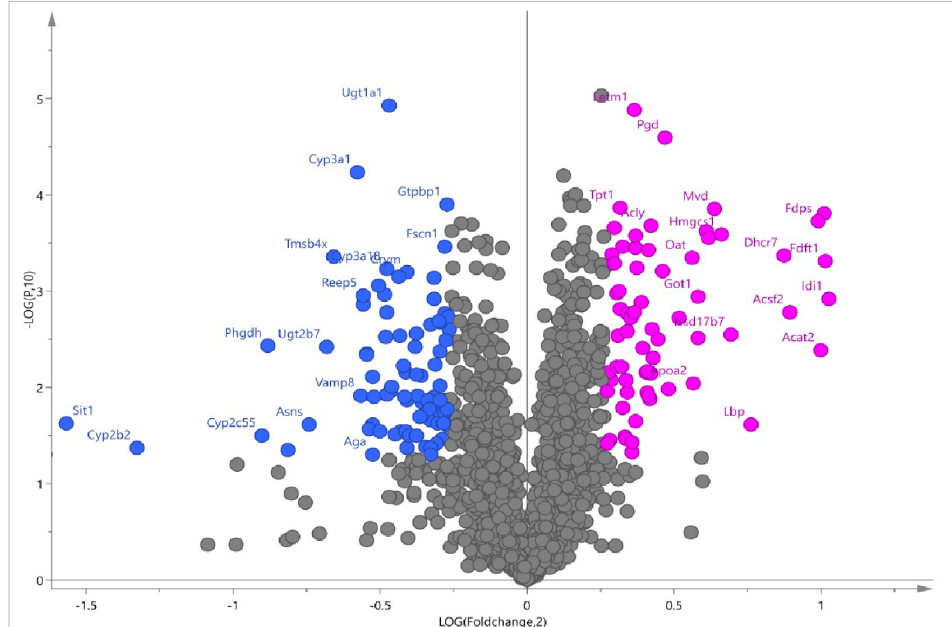
Fig 2. Differential proteins in liver tissues of rats between normal control and MetS groups. Rose red circle represents up-regulated protein and blue circle represents down-regulated protein.